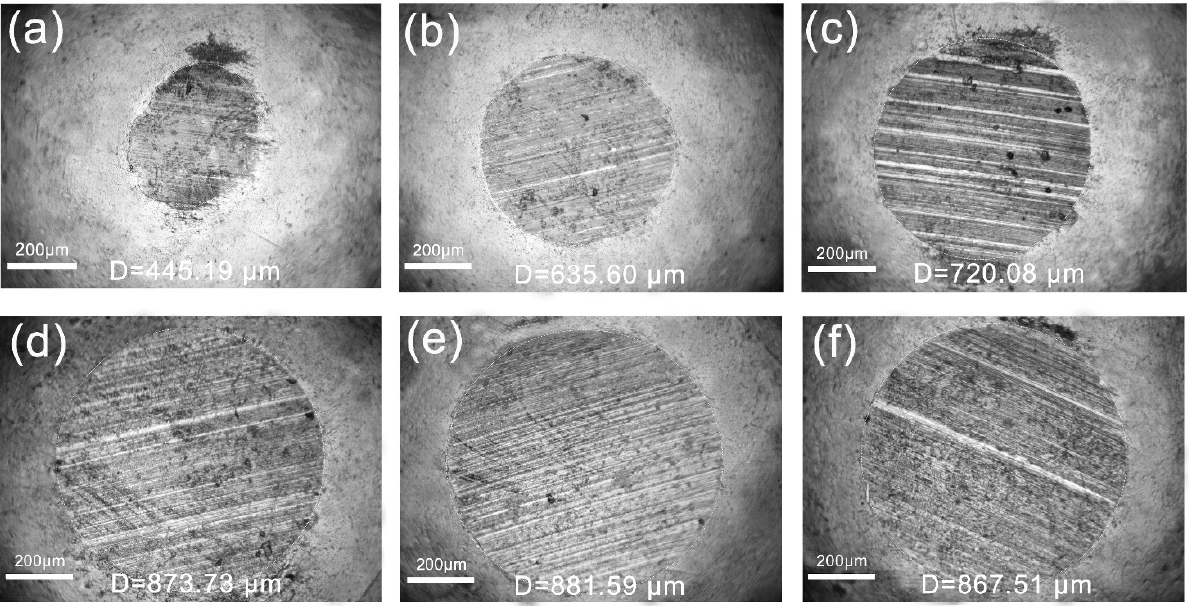
Figure 13. Wear spot of greases with different consistencies: ( a ) Li-230, ( b ) Li-250, ( c ) Li-300, ( d )Po-230, ( e ) Po-250, ( f ) Po-300.